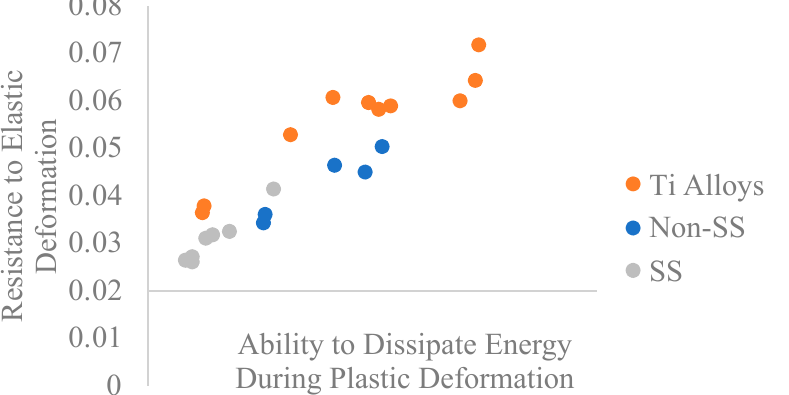
Figure 38. Plots the resistance to elastic deformation and the ability to dissipate energy during plastic deformation alongside one another for the same three clusters of powder.